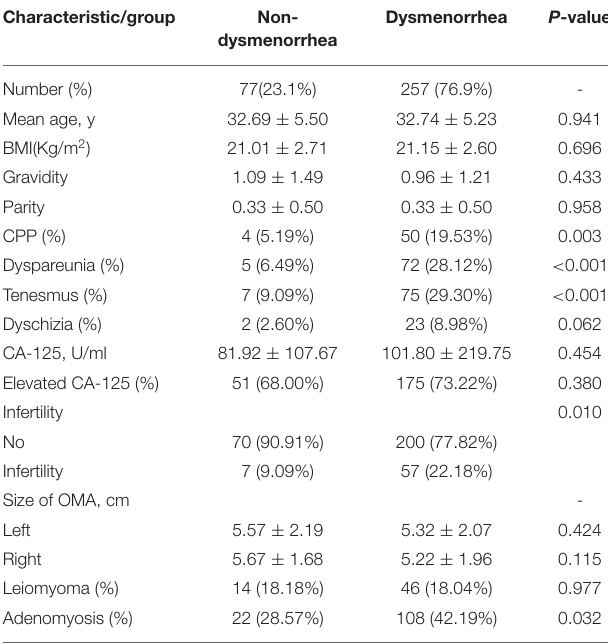
TABLE 1 | Comparison of demographic and clinical